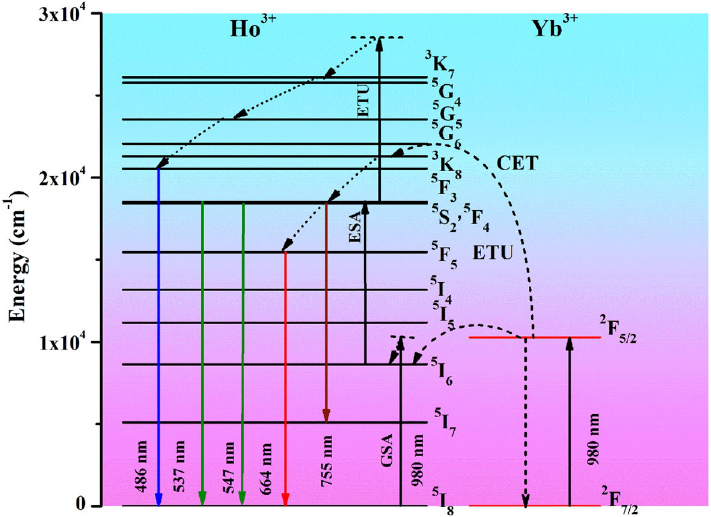
Figure 9. The energy level diagrams of Ho 3+ and Yb 3+ ions along with upconversion mechanism.